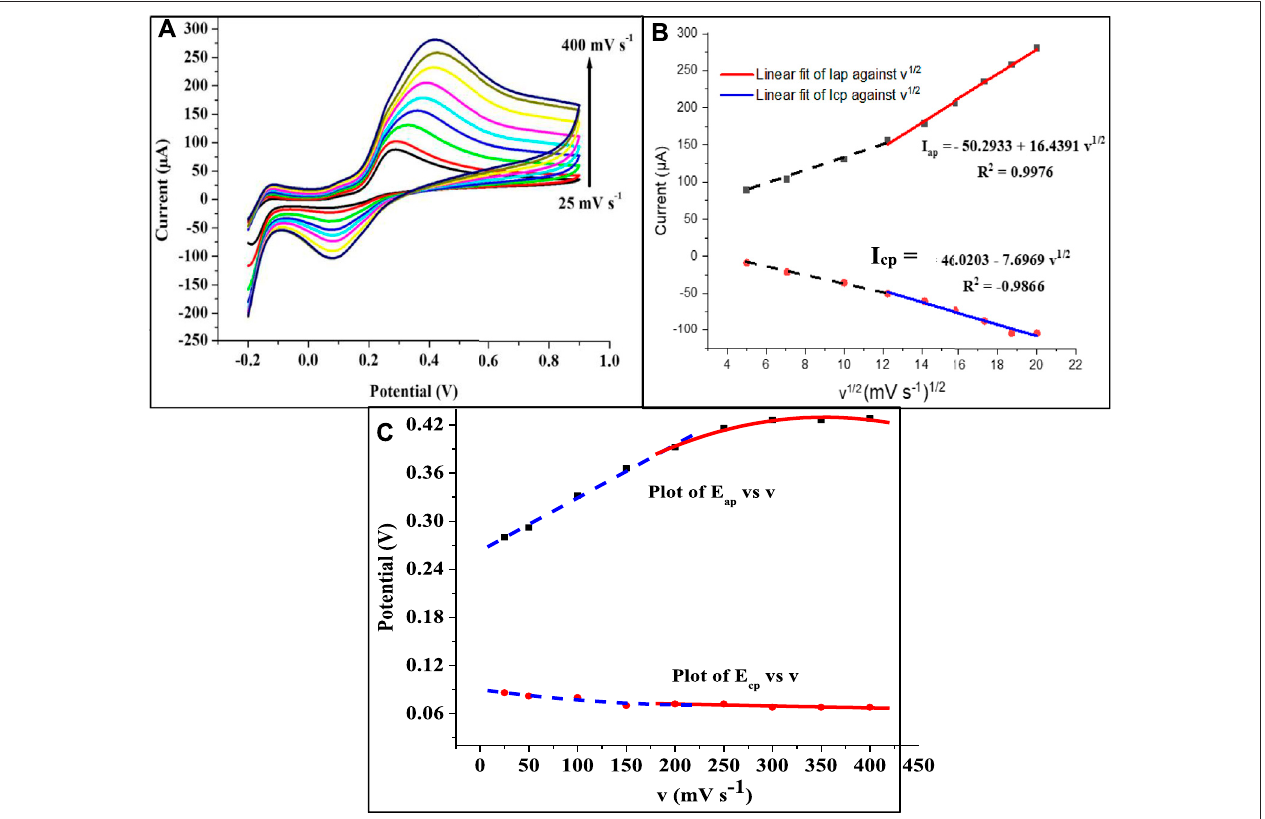
FIGURE7|(A) Cyclicvoltammograms showingtheeffectofscanrate(v) onEPoxidation at SPSE/Fe 3 O 4 (1 mM EPat scanrate of25 – 400 mV s − 1 , pH7). (B) Plot of peak current against the square root of v and (C) Plot of potential against v.